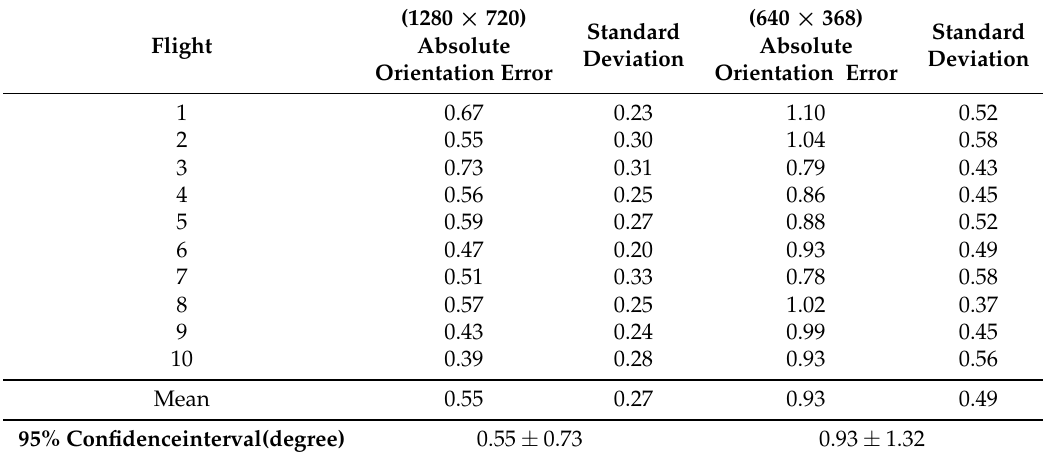
Table 5. Absolute orientation statistics for 10